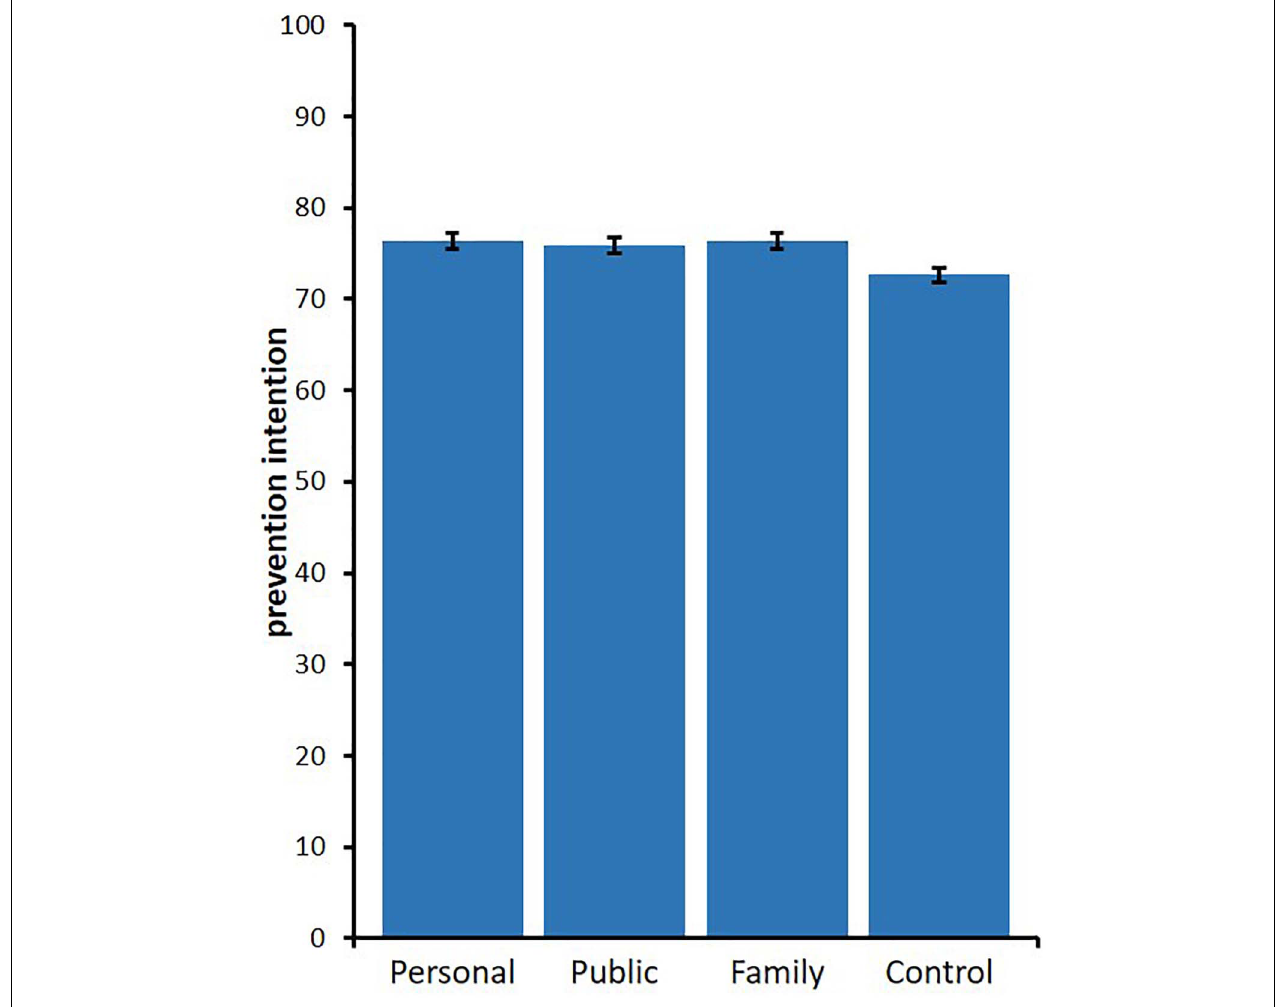
FIGURE 4 | Means of prevention intention per treatments in Study 2 (error bars depict standard